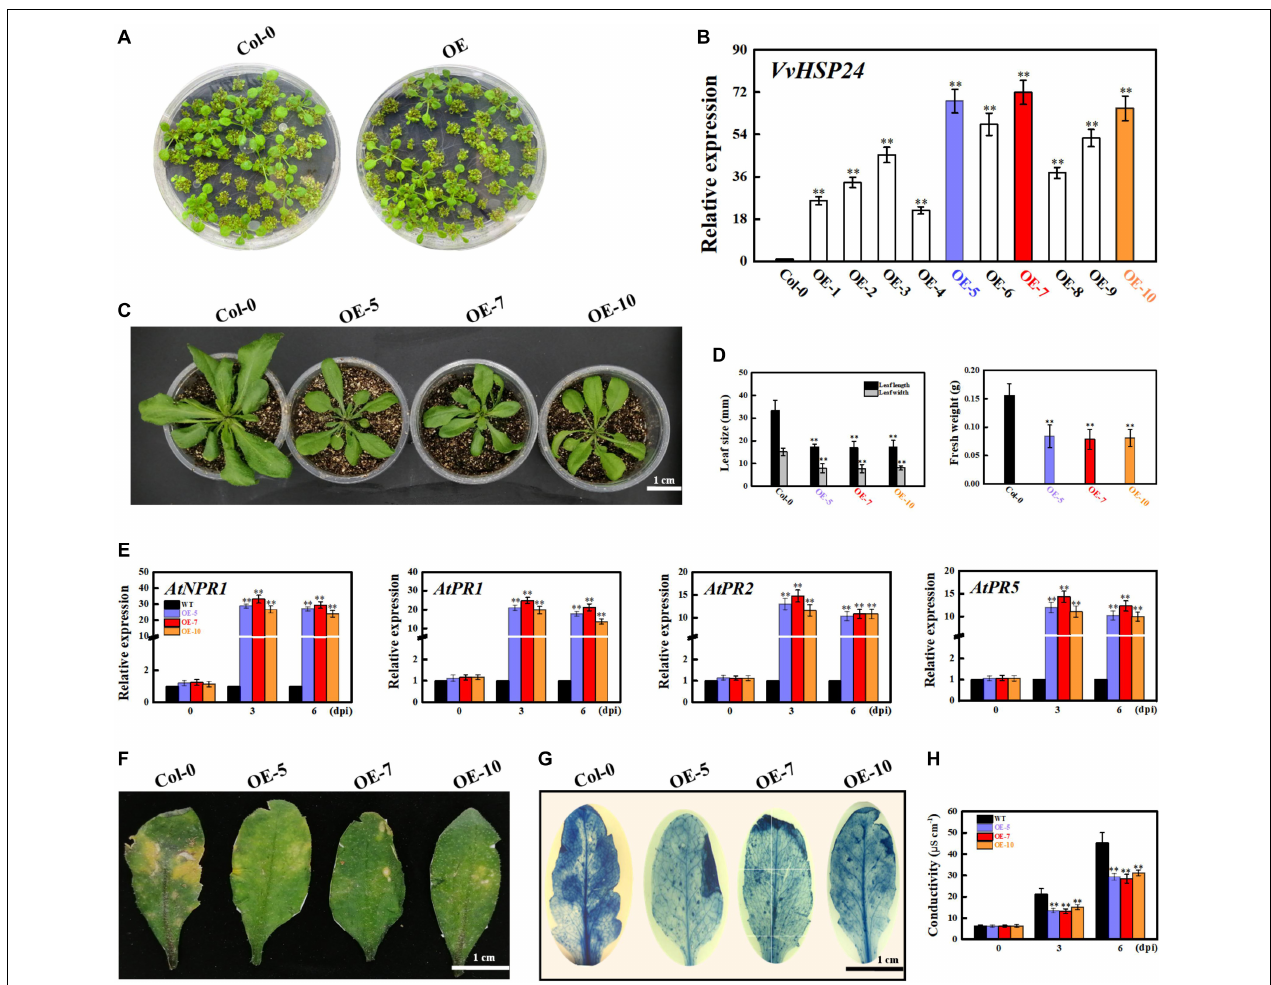
FIGURE 7 | Overexpression of VvHSP24 activates PR gene expression in Arabidopsis leaves and increases the resistance of transgenic Arabidopsis to the fungal pathogen B. cinerea . (A) Phenotypes of Arabidopsis Col-0 wildtype and transgenic seedlings for 2 weeks. (B) Relative mRNA levels of VvHSP24 in Col-0 wildtype and transgenic Arabidopsis plants grown in soil for 4 weeks. Transcript abundances are expressed relative to the reference gene of AtActin2 and expressed as the mean ± SE. Two asterisks indicate significant differences between wildtype and transgenic plants ( p < 0.01). (C,D) Overexpression of VvHSP24 in Arabidopsis inhibits growth, as exhibited by the shorter leaf length and lower biomass of the dominant VvHSP24 -overexpressing Arabidopsis (OE5, OE7, and OE10) than of Col-0 wildtype. Bar = 1 cm. (E) qRT-PCR analysis of the transcript levels of defense-related genes (NPR1, PR1 , PR2, and PR5 ) in Col-0 wildtype and VvHSP24 -overexpressing Arabidopsis (OE5, OE7, and OE10) infected by B. cinerea at 0, 3, and 6 dpi. mRNA expression levels were quantified against the value of AtActin2 ; the data represent the mean ± SE of three separate replicates. Two asterisks indicate significant differences between wildtype and OE5, OE7, or OE10 ( p < 0.01). (F) Disease symptoms of wildtype and VvHSP24 -overexpressing (OE-5, OE-7, and OE-10) Arabidopsis leaves after B. cinerea infection at 6 dpi. Bar = 1 cm. (G) Necrotic areas in Col-0 wildtype and VvHSP24 -overexpressing Arabidopsis leaves were determined by trypan blue staining after B. cinerea infection at 6 dpi, and images were captured with a digital camera. (H) Measurement of electrolyte leakage from wildtype and VvHSP24 -overexpressing Arabidopsis leaves infected with B. cinerea at 6 dpi. Conductivities are expressed as the mean and SE of three independent biological replicates. Two asterisks indicate significant differences between wildtype and VvHSP24 -overexpressing Arabidopsis at p =